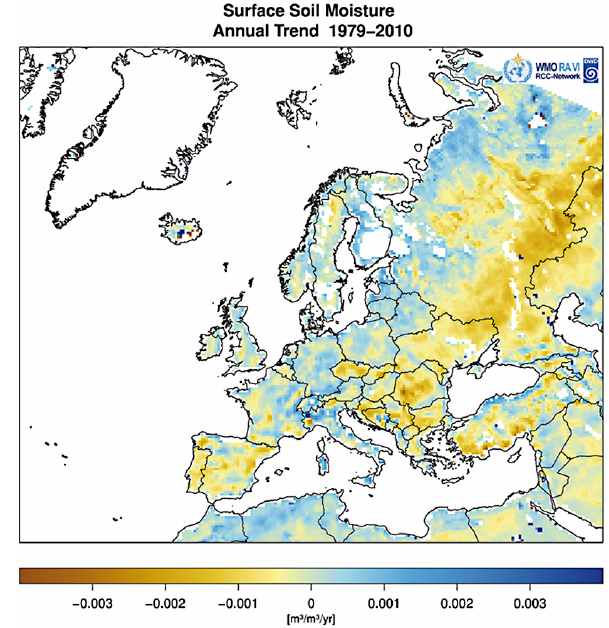
Figure 5. Annual trend in surface soil moisture for the period 1979– 2010, based on a harmonized data set of active and passive mi- crowave observations provided by the ESA Soil Moisture